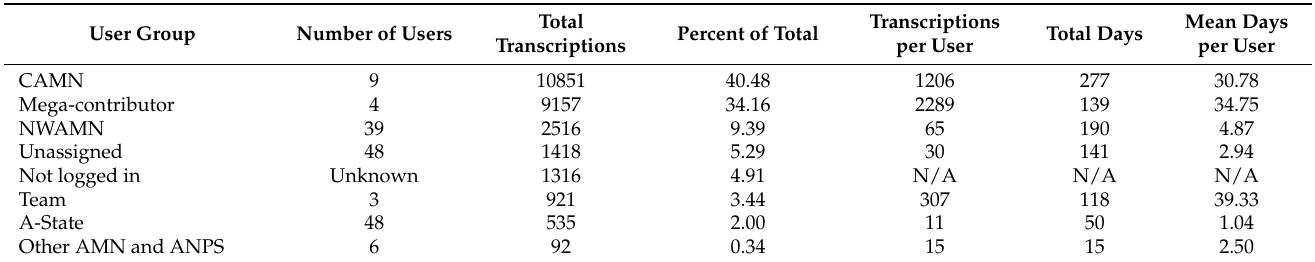
Table 1. User groups organized by the total number of transcriptions produced by each group (as in [43]). Unassigned includes usernames that were not recognized to belong to a particular group. User groups included Mega-contributor for global users completing > 10,000 transcriptions on the Plants of Arkansas project, Team for members of the Plants of Arkansas core team who are the lead researchers and project moderators, CAMN for users in Central Arkansas Master Naturalists organization (engaged January 2019), NWAMN for users in Northwest Arkansas Master Naturalists organization (trained January 2020), combined Arkansas Master Naturalist groups (Northeast Arkansas and Diamond Lakes) with Arkansas Native Plant Society (ANPS) members, and students from